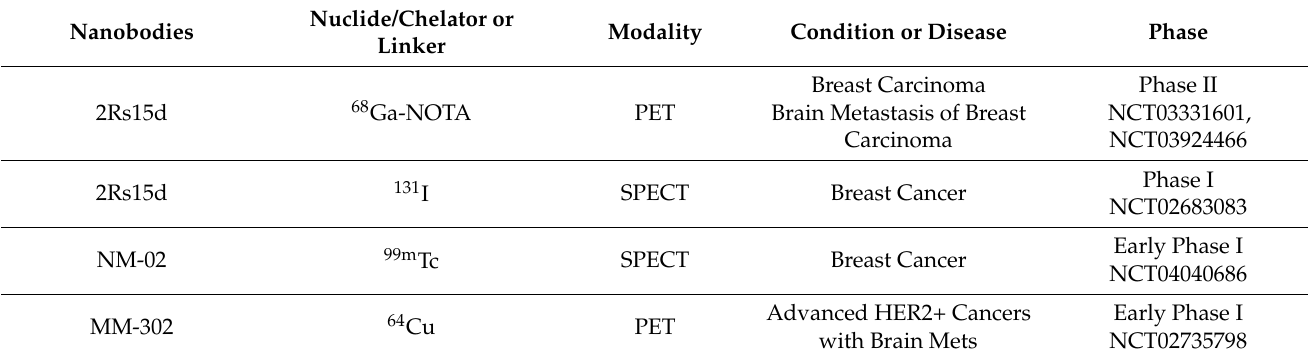
Table 3. The clinical trials of HER2-targeted